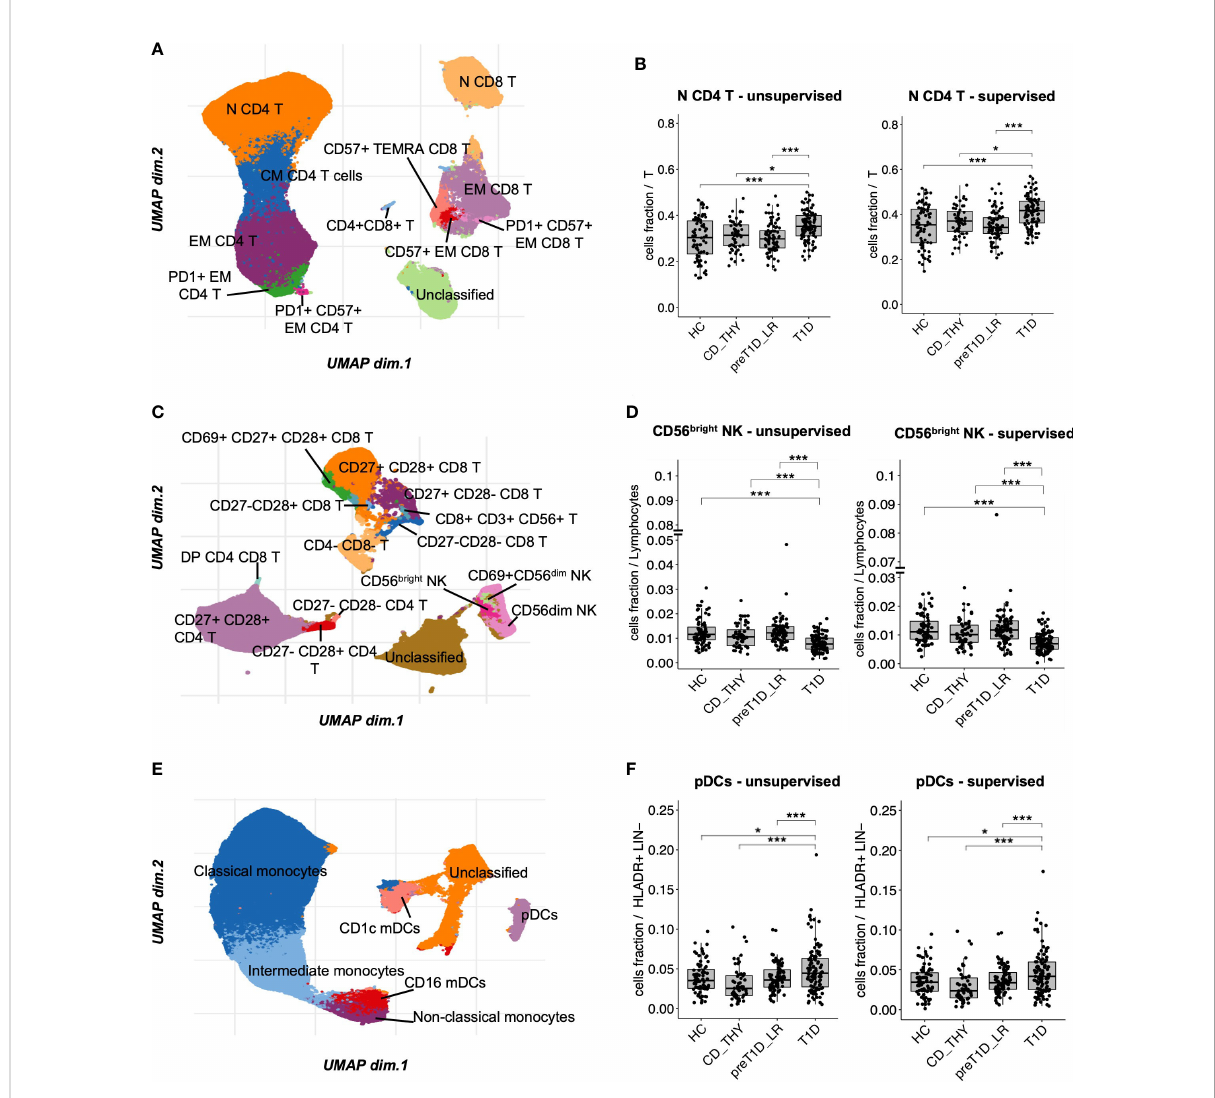
FIGURE 2 Unsupervised clustering shows increased frequency of N CD4 T cells and pDCs, and reduced frequency of CD56bright NK cells in T1D. UMAP data visualization of the cell clusters identi fi ed in the T cell (A) , T&NK cell (C) and DCs/monos (E) panels. Cell clusters differentially represented in T1D compared to all other groups in the T cell (B) , T&NK cell (D) and DC/mono (F) panels. HC, healthy controls; CD_THY, celiac or thyroid diseases; preT1D_LR, relatives with 0-1 autoantibodies; T1D, type 1 diabetes. Signi fi cant differences were determined by post hoc Tukey ’ s test performed on the linear regression model with age, sex, and technician as covariates (*p < 0.05, ***p <